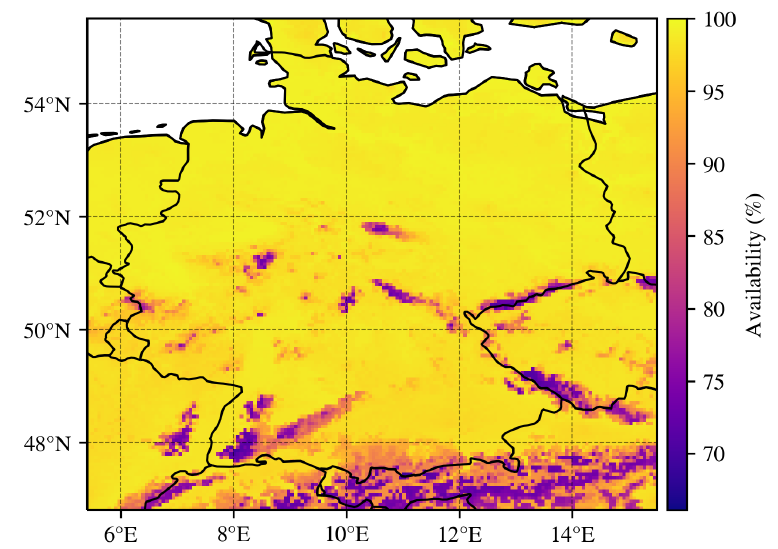
Figure 7. Map of estimated availability based on CBA ≤ 100m frequency (2006–2017) and assumed 10-min availability threshold of 80% at measurement heights of 130m and